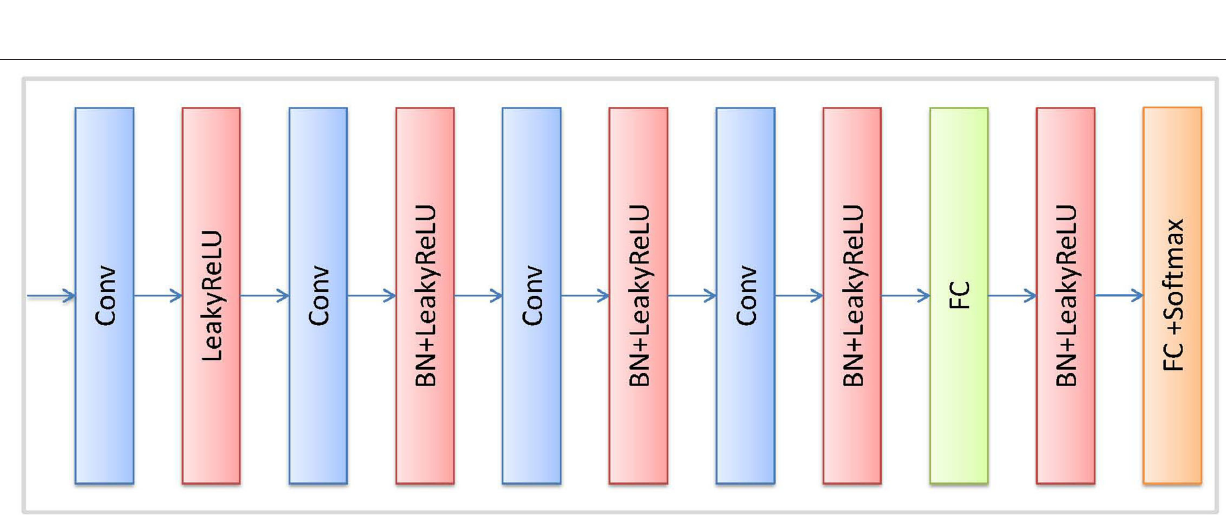
FIGURE 2 | The architecture of COL-Net. “UL”: unlabeled image; “L”: labeled image; “R”: reconstruction network; “S”: segmentation network; “T”: transfer block.